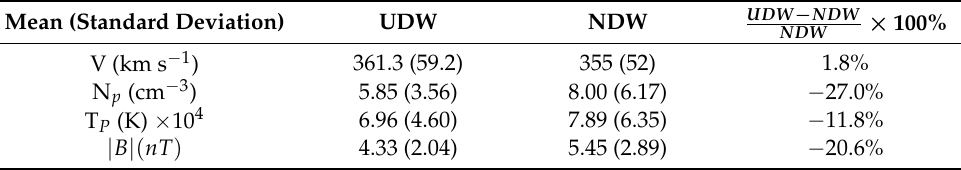
Table 3. Averages, standard deviations, and changing rates of the proton speed (V), density (N p ), temperature (T p ) and the magnitude of the magnetic field ( | B | ) of the UDW and NDW measurements from ACE/SWEPAM and MAG during